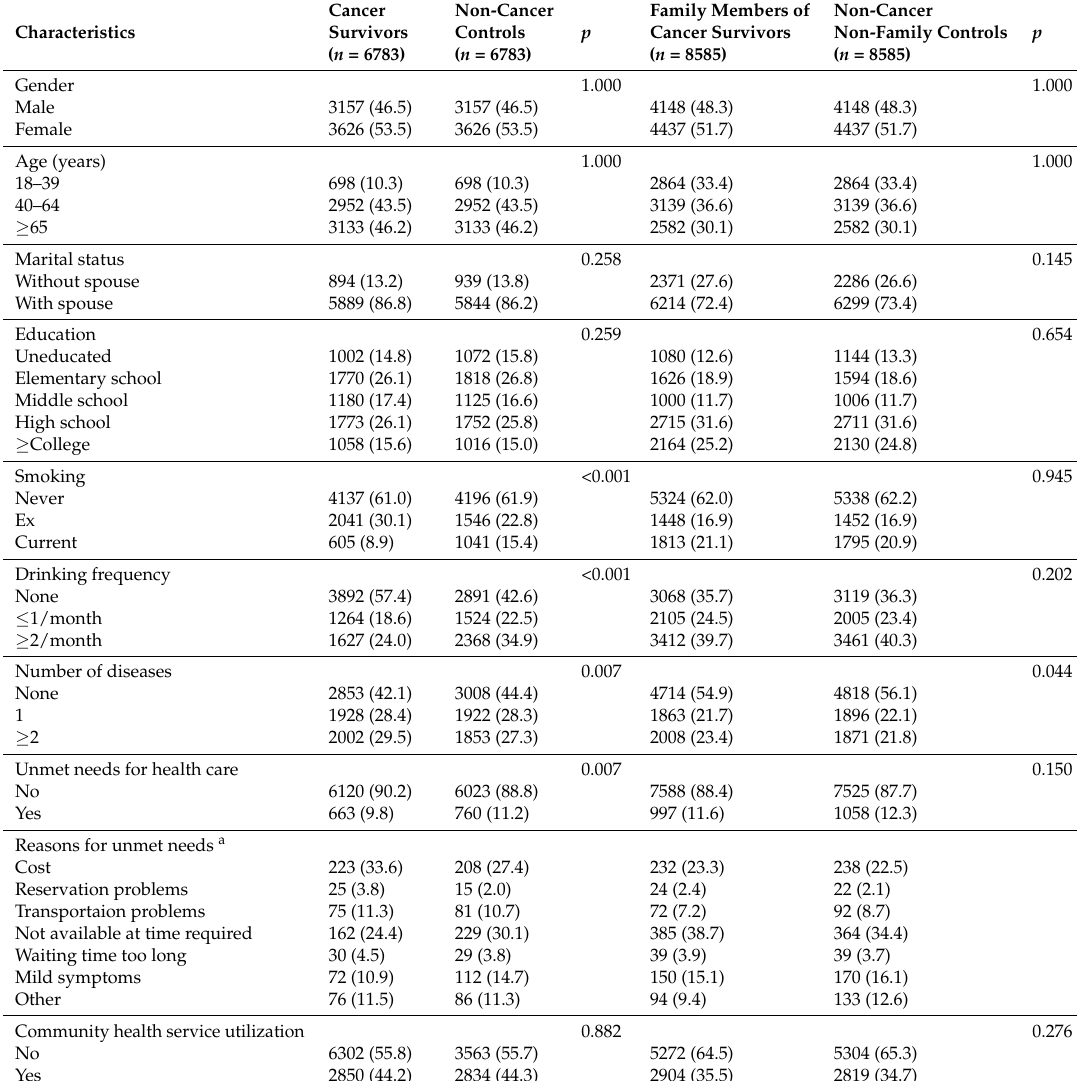
Table 1. Characteristics of cancer survivors, family members, and